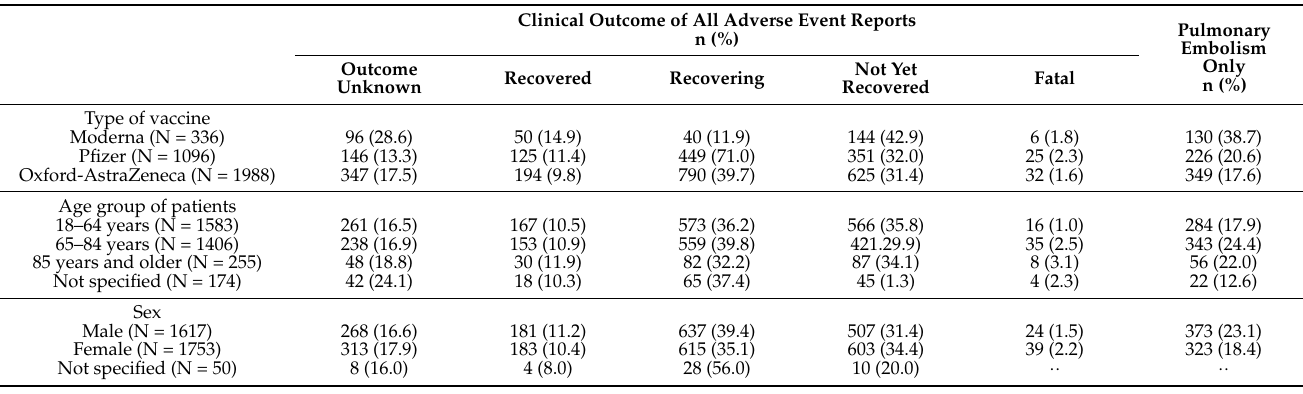
Table 3. Clinical outcome of all adverse events from 17 February to 14 June 2021 with demographic variables related to Moderna, Pfizer and Oxford-AstraZeneca vaccines with a focus on pulmonary embolism. Clinical Outcome of All Adverse Event Reports n